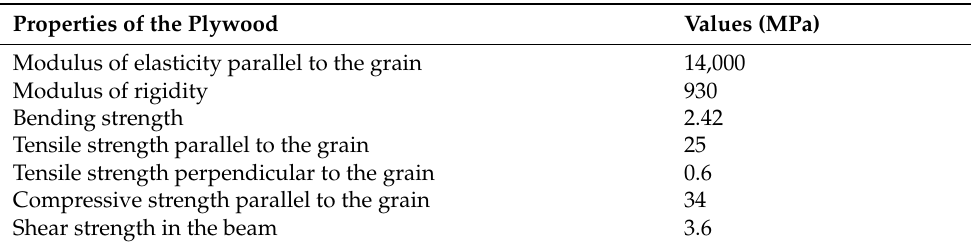
Table 3. The mechanical properties of the plywood used as a spline.